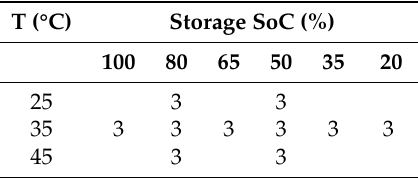
Table 3. Calendar aging test matrix with number of